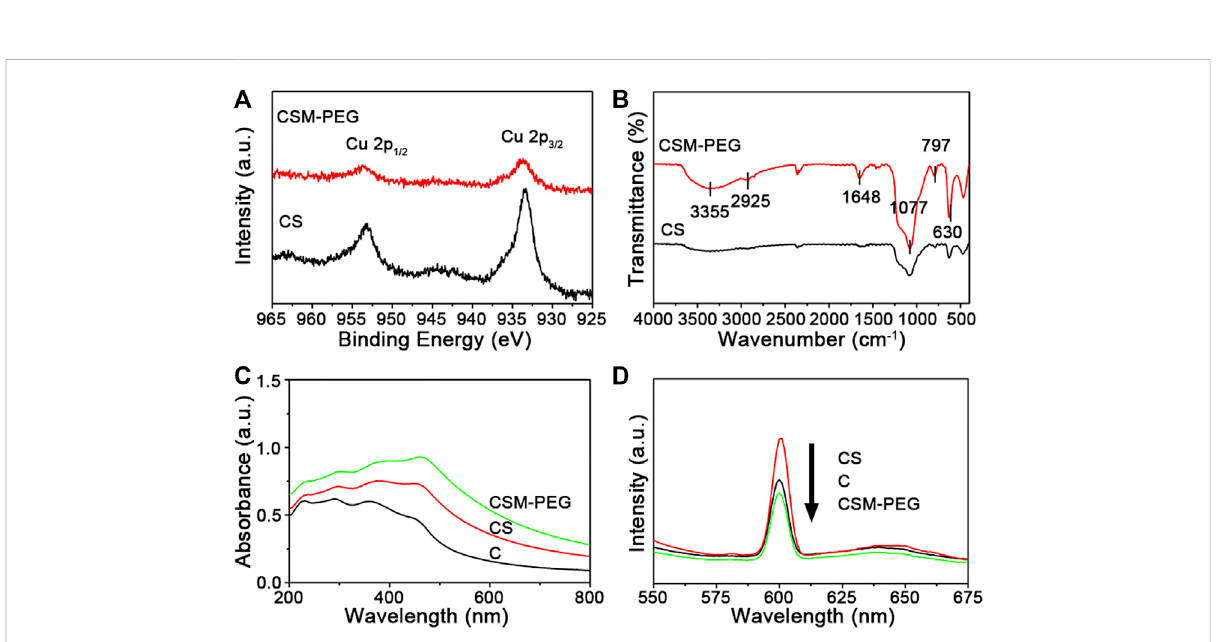
FIGURE 3 (A) Cu 2p XPS spectra for Cu 2 O@SiO 2 and Cu 2 O@SiO 2 /MnO 2 − PEG. (B) FT − IR spectra for Cu 2 O@SiO 2 and Cu 2 O@SiO 2 /MnO 2 − PEG. (C) UV − Vis spectra for